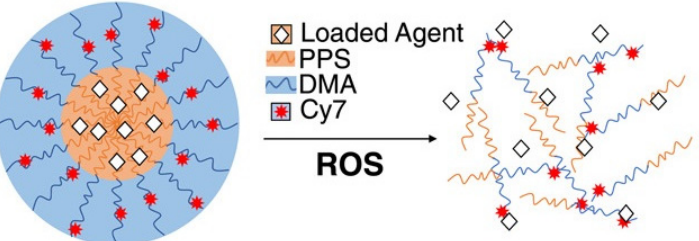
Figure 2. Schematic representation of poly(propylene sulfide) nanocarriers with loaded pharmaceu- tical agents. PPS—poly(propylene sulfide); DMA—N,N-dimethylacrylamide; Cy7—Cy7-amine, a fluorescent marker; ROS—reactive oxygen species. Reproduced from [23], with permission from John Wiley and Sons, 2021.